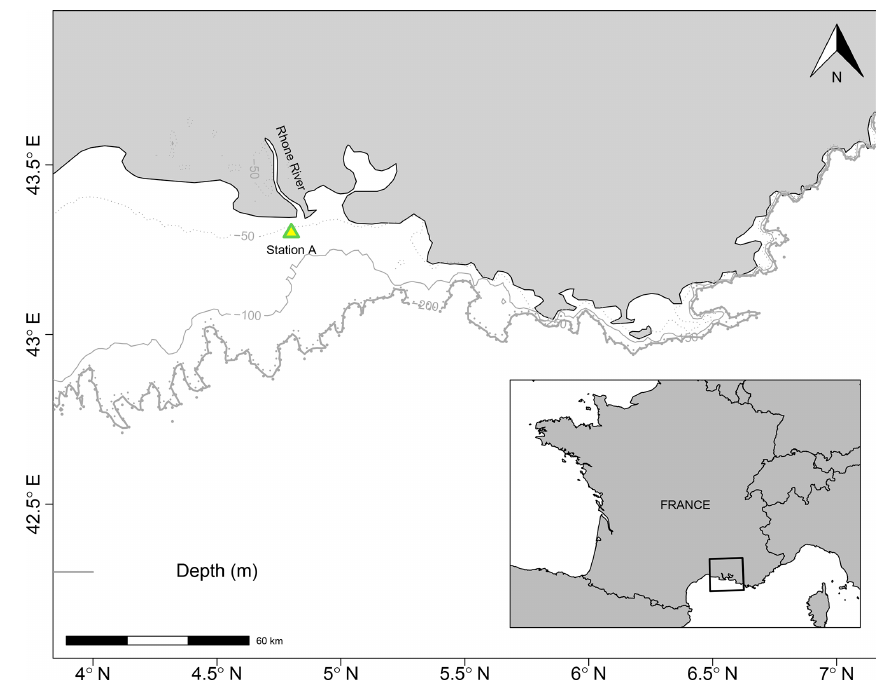
Figure 1. Map showing the locations of sampling sites off the Rhône River